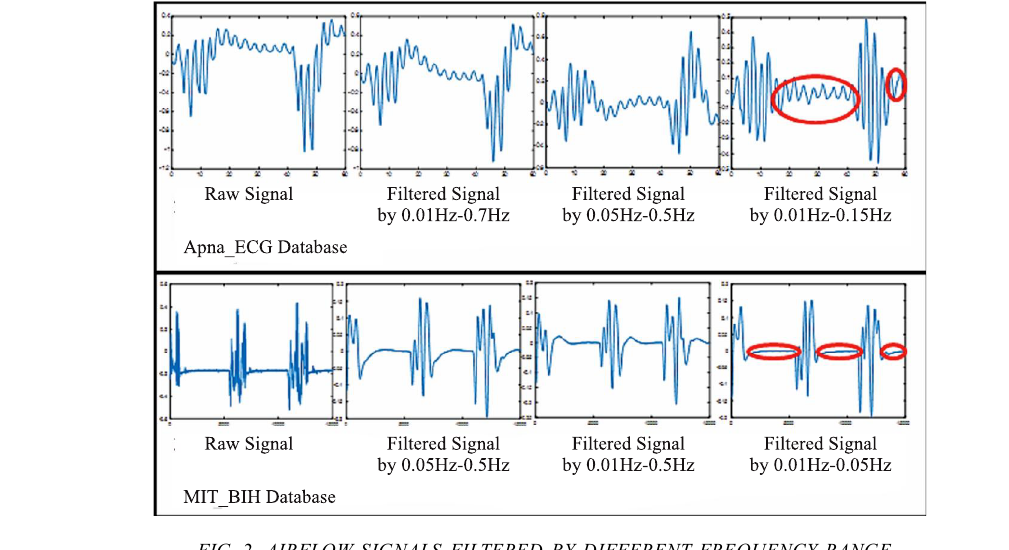
FIG. 2. AIRFLOW SIGNALS FILTERED BY DIFFERENT FREQUENCY